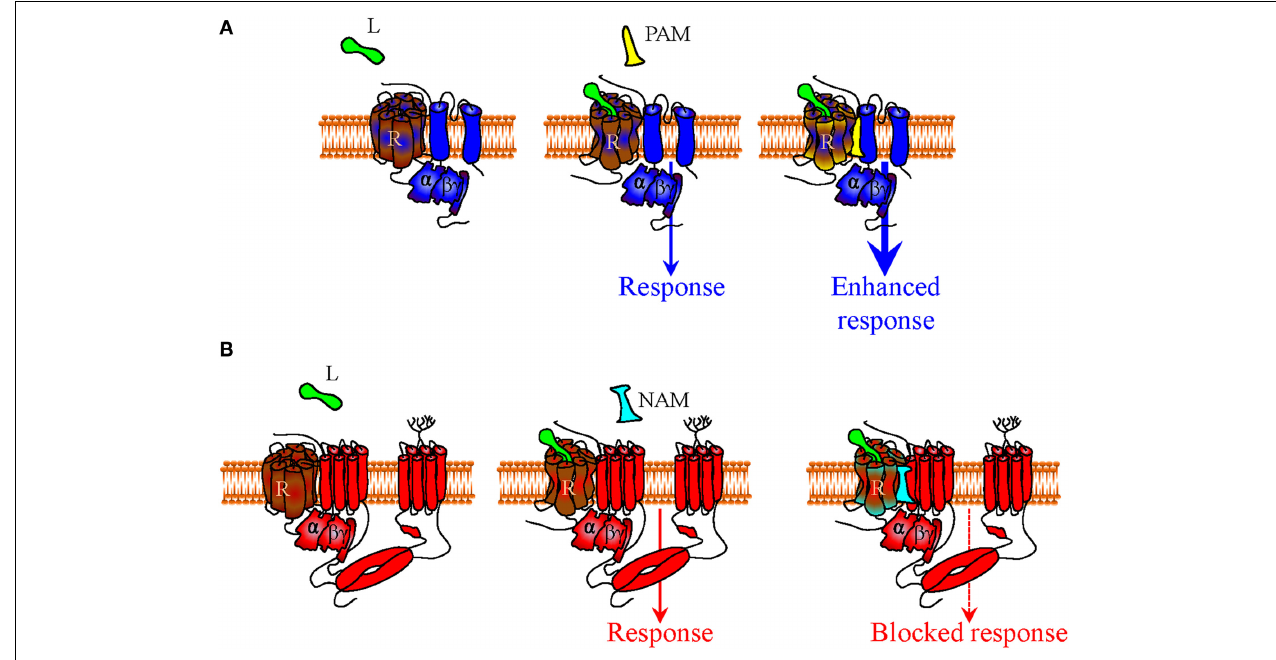
FIGURE 3 | Mechanisms of indirect bias involving allosteric modulators that specifically recognize a complex of desired composition. In a precoupling model or in a restricted collision model receptors, G proteins and effectors may all persistently associate during signaling. Within this context (only precoupling model represented in figure), small positive allosteric modulators (PAM ) that specifically recognize the interface between DORs